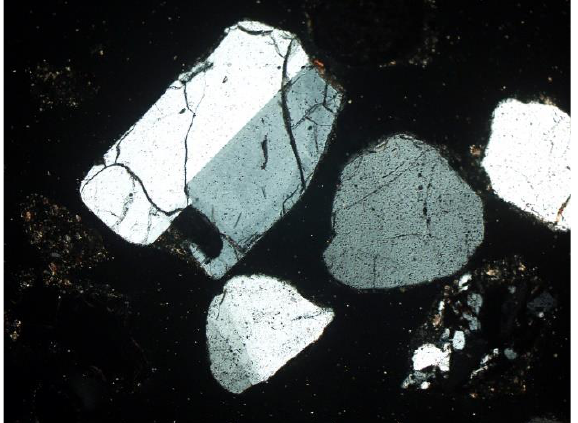
Figure 12. Potassium feldspar, double twinned (orthoclase) surrounded by quartz grains. SP2 sample, thin section, 2P, 200×, transmitted light.